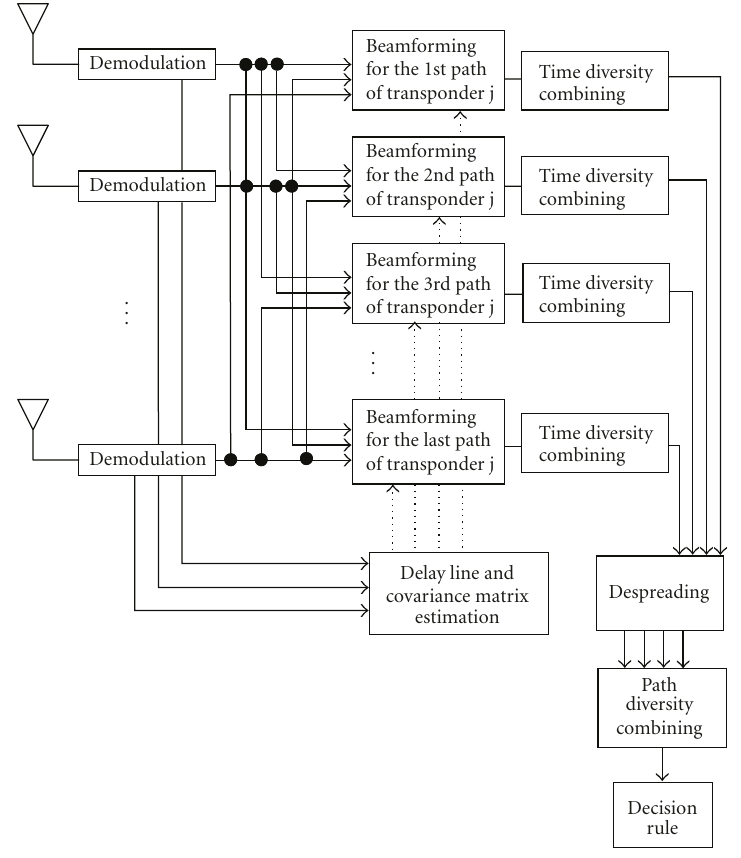
Figure 7: Receiver structure with using cyclostationarity.